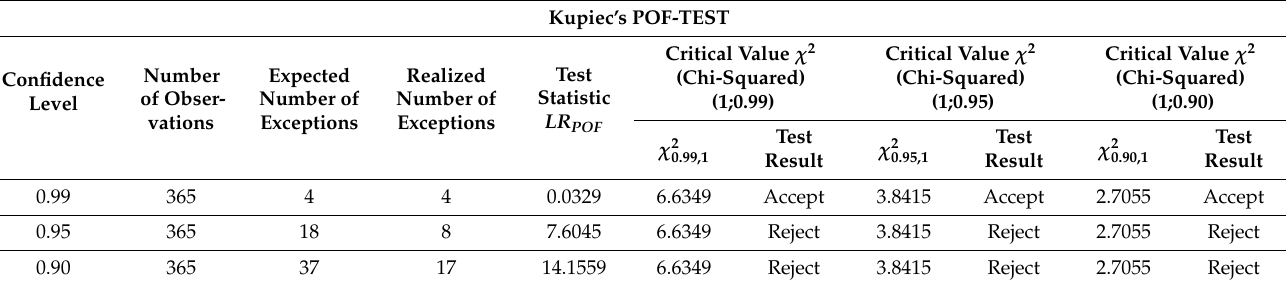
Table 10. Monte Carlo simulation VaR Kupiec’s POF-test.